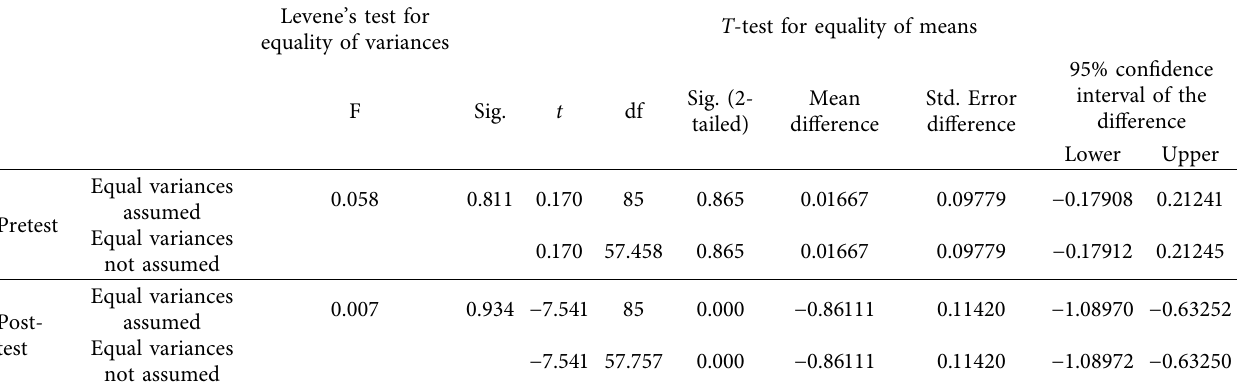
Table 3: Investigating the differences between the two groups’ speaking skill scores. Independent samples test